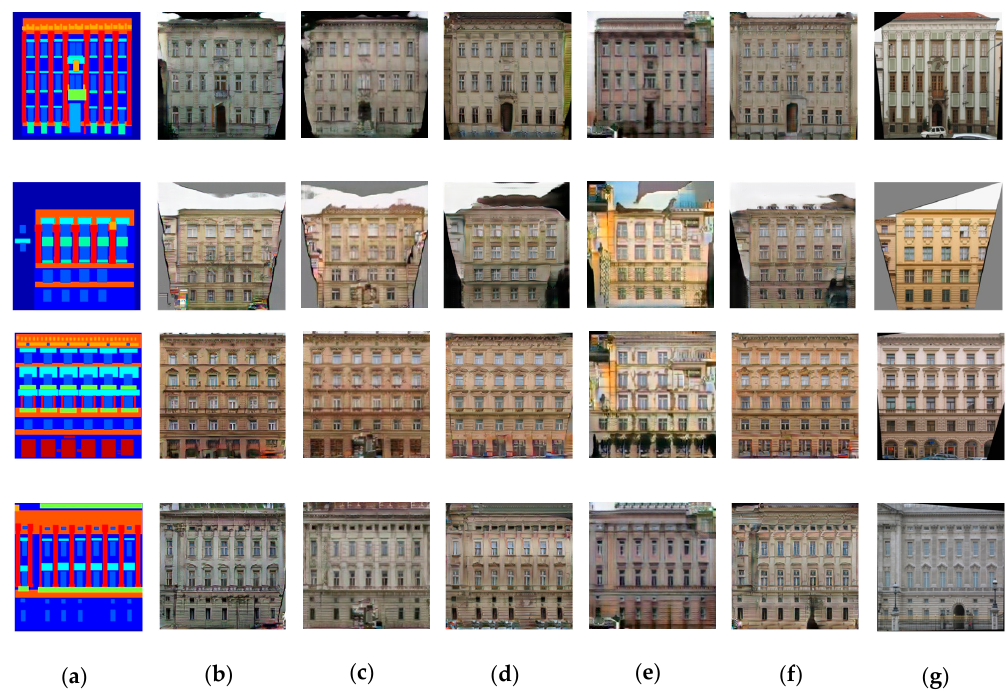
Figure 7. Samples results from paired labels to architectural photos. ( a ) input images, ( b ) results of pix2pix-cGAN, ( c ) results of UTN-GAN, ( d ) results of PAN, ( e ) results of iPANs, ( f ) results of the IP-RAN, and ( g ) targeted photos.